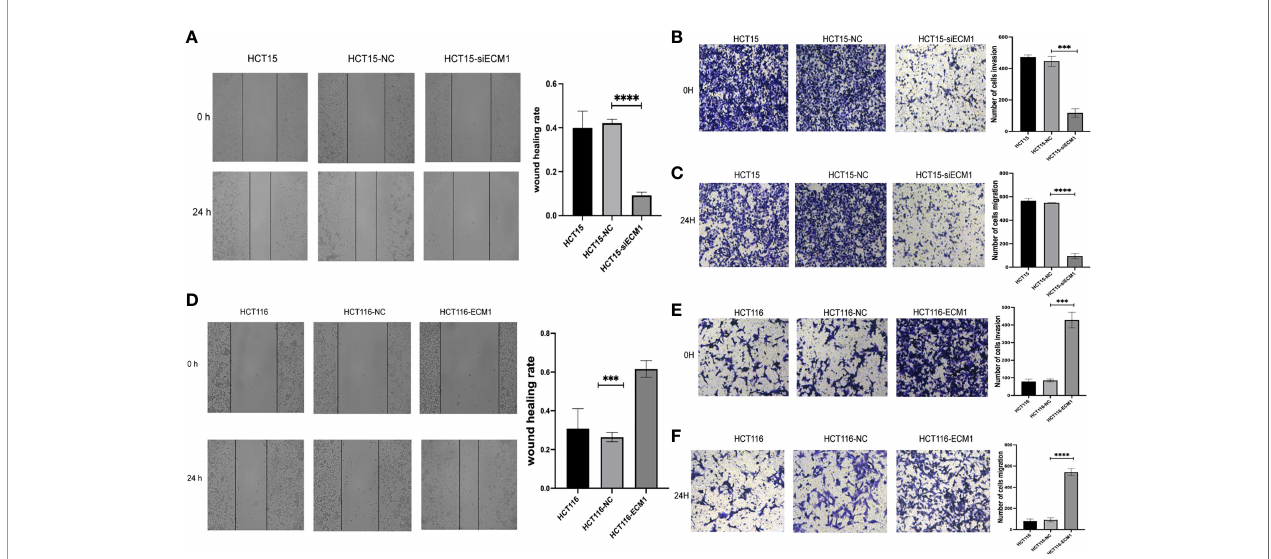
FIGURE 4 | ECM1 regulates CRC cell invasion and migration. CRC cell migratory and invasive activity were scrutinized through Transwell and wound healing assessments following ECM1 knockdown (A – C) or upregulation (D – F) . Data are means ± SD (***P < 0.001, ****P < 0.0001).